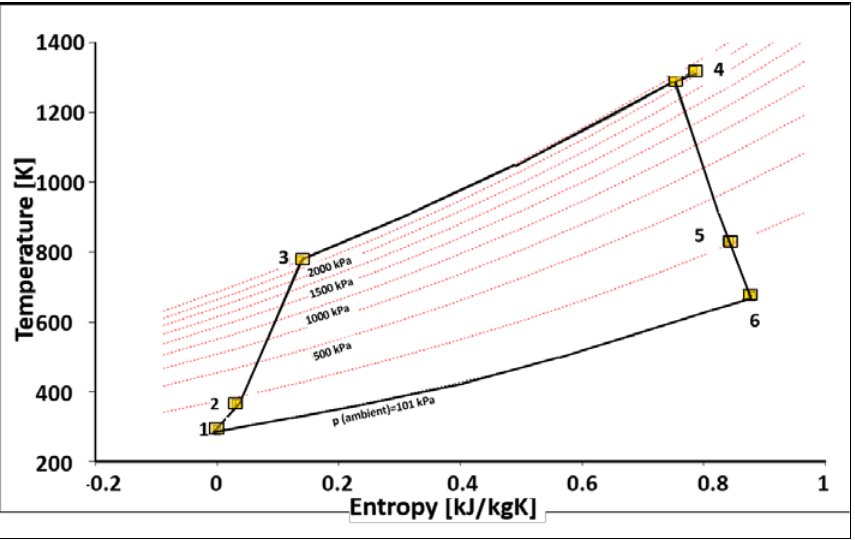
Figure 16. Thermodynamic cycle for Engine_3 at the design point. Figure 6. Thermodynamic cycle for Engine_3 at the design point. Figure 6. Thermodynamic cycle for Engine_3 at the design point.